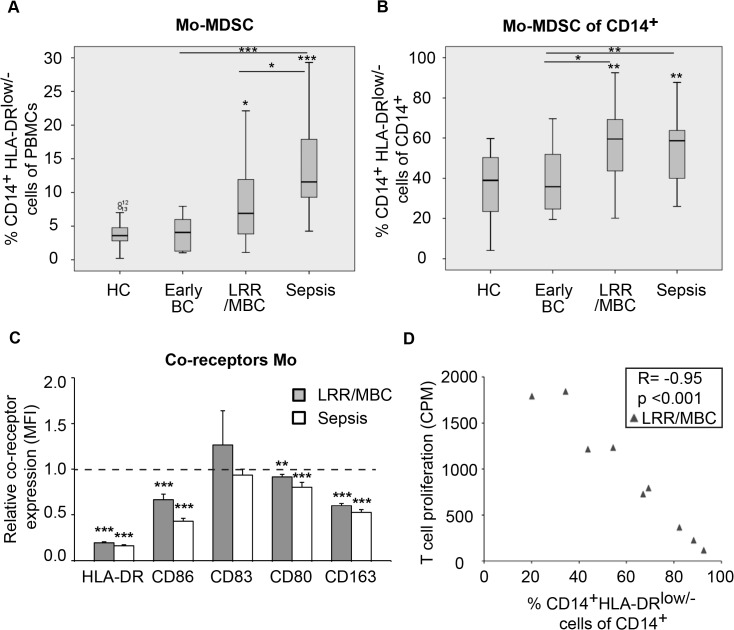
Increased frequency of Mo-MDSCs (CD14+HLA-DRlow/-Co-receptorlow/-) in patients with advanced breast cancer.Flow cytometric analyzes of freshly isolated PBMCs from healthy controls (HC), patients with early breast cancer (BC), patients with advanced breast cancer (LRR/MBC) and patients with sepsis. (A) The box plots represent the percentage of CD14+HLA-DRlow/- Mo-MDSC of PBMCs or (B) within total CD14+ monocyte population, HC n = 13, Early BC n = 10, LRR/MBC n = 25 and sepsis n = 18. Statistics were performed using Mann-Whitney Wilcoxon test. * p < 0.05, ** p < 0.01, *** p < 0.001. (C) Relative expression (mean fluorescence intensity; MFI) of co-receptors on CD14+HLA-DRlow/- monocytes from patients with LRR/MBC (grey) or sepsis (white) compared to CD14+HLA-DR++monocytes. Co-receptor expression on CD14+HLA-DR++ cells put to 1. Columns, mean; bars, SEM. Students t-test ** p < 0.01, *** p < 0.001. (D) T cell proliferation (CPM) in vitro at stimulator:responder ratio 0.01:1 correlates inversely with the percentage of Mo-MDSC within total CD14+ monocyte population. LRR/MBC n = 9, Spearman’s rho correlation.